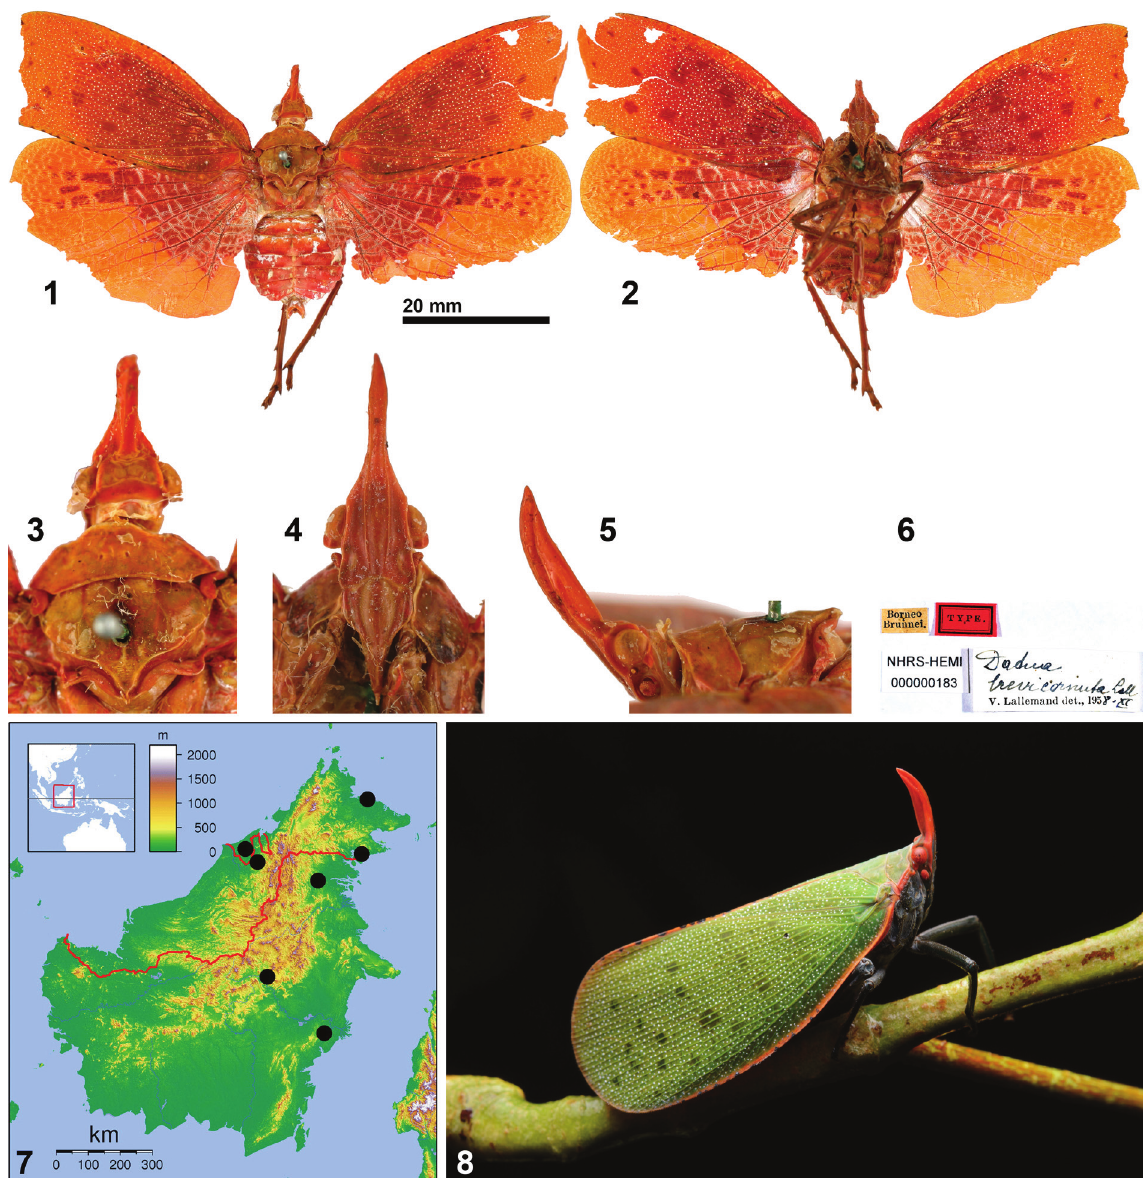
Figs 1–8. 1-6, Egregia brevirostris (Lallemand, 1959), holotype, ♀. 1 . Dorsal view. 2 . Ventral view. 3 . Head and pronotum: dorsal view. 4 . Frons: normal view. 5 . Head and thorax: left lateral view (Figs 3-5 not to scale). 6 . Labels. 7 . Distribution map. 8 . Specimen in nature at night, Sarawak, Mulu National Park, 50 m asl (photograph by Ch’ien C. Lee –